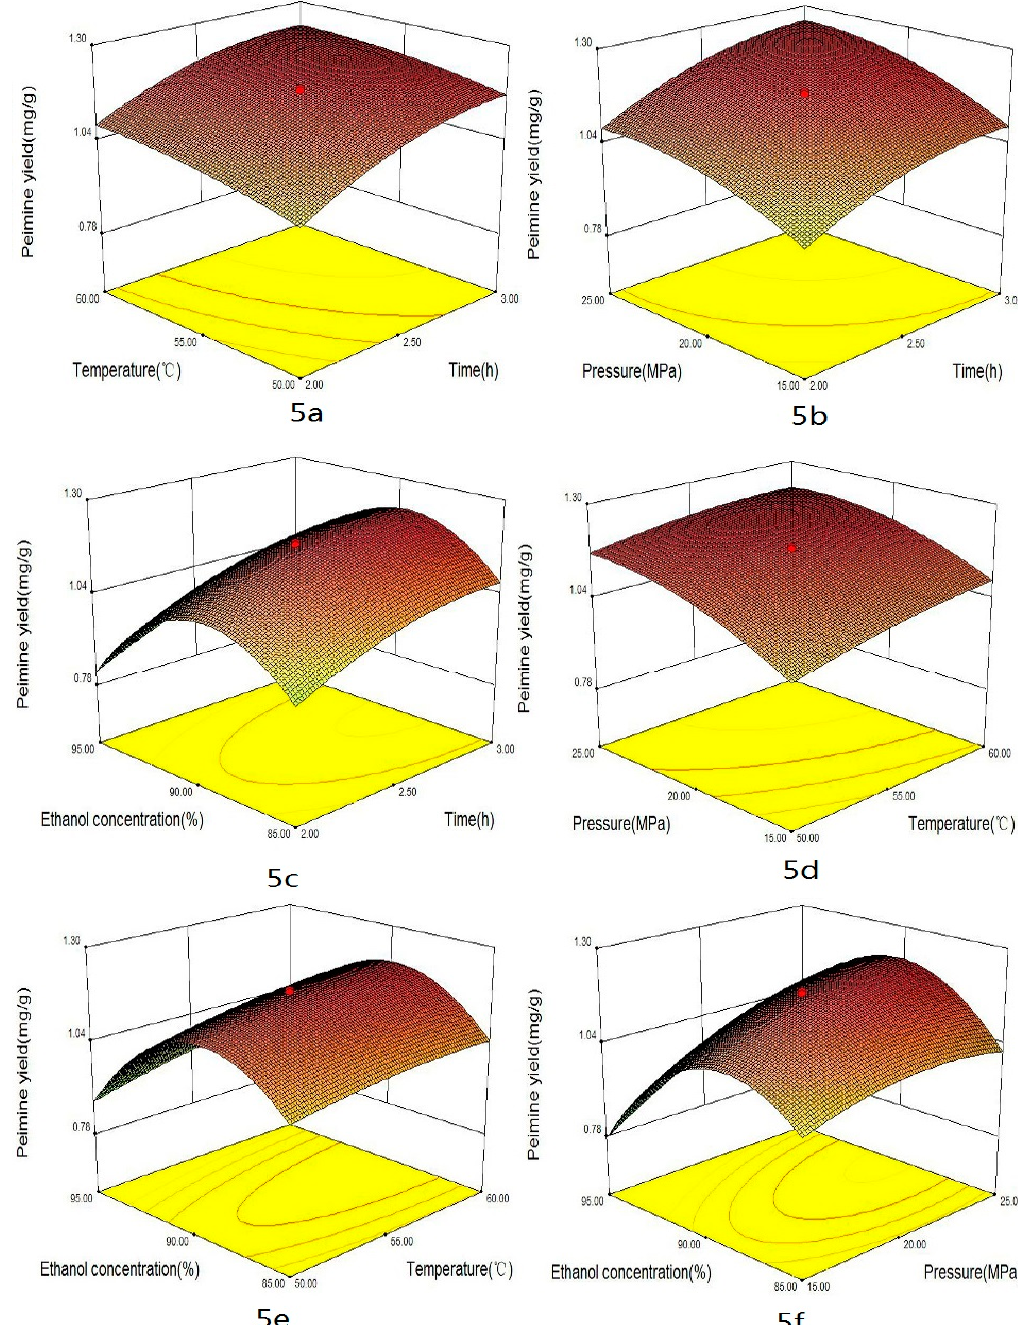
Figure 5. Response surface plots of peimine yields showing: ( a ) the effect of time and temperature at constant pressure (20 MPa) and ethanol concentration (90%); ( b ) the effect of time and pressure at constant temperature (55 °C) and ethanol concentration (90%); ( c ) the effect of time and ethanol concentration at constant temperature (55 °C) and pressure (20 MPa); ( d ) the effect of temperature and pressure at constant time (2.5 h) and ethanol concentration (90%); ( e ) the effect of temperature and ethanol concentration at constant time (2.5 h) and pressure (20 MPa); and ( f ) the effect of pressure and ethanol concentration at constant time (2.5 h) and temperature (55 °C).